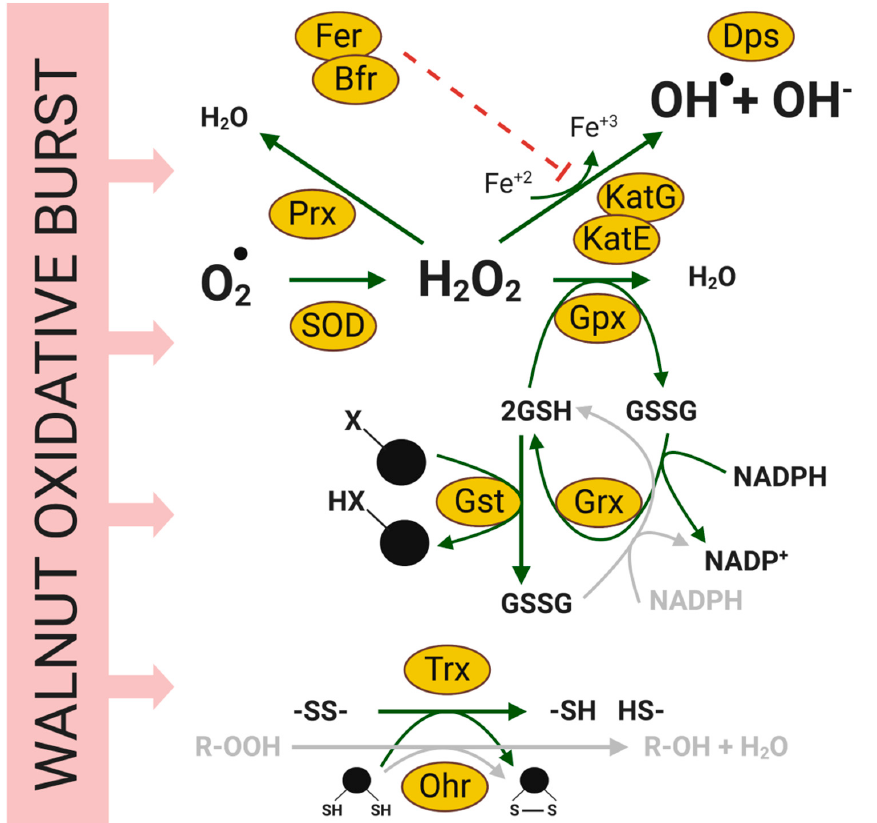
Figure 8. Oxidative stress in response to walnut bacterial blight. Reactive oxygen species (ROS) enzymes represent bacterial proteins identified in the Xaj proteome. Fer: ferritin, Bfr: bacterioferritin, Dps: DNA-binding proteins/ferretins, Ohr: organic hydroperoxide resistance protein, Trx: thioredoxin, Kat: catalase, SOD: superoxide dismutase, Prx: peroxiredoxin, Gpx: glutathione peroxidase, Grx: glutaredoxin, Gst: glutathione transferase.